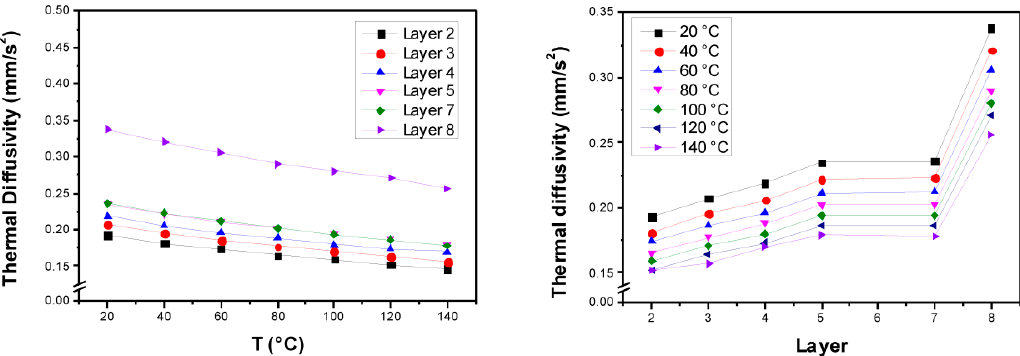
Figure 6. ( Left ) Thermal diffusivity a ( T ) of the different layers according to laser flash analysis (LFA) measurements. ( Right ) Gradient of the thermal diffusivity along the different layers.